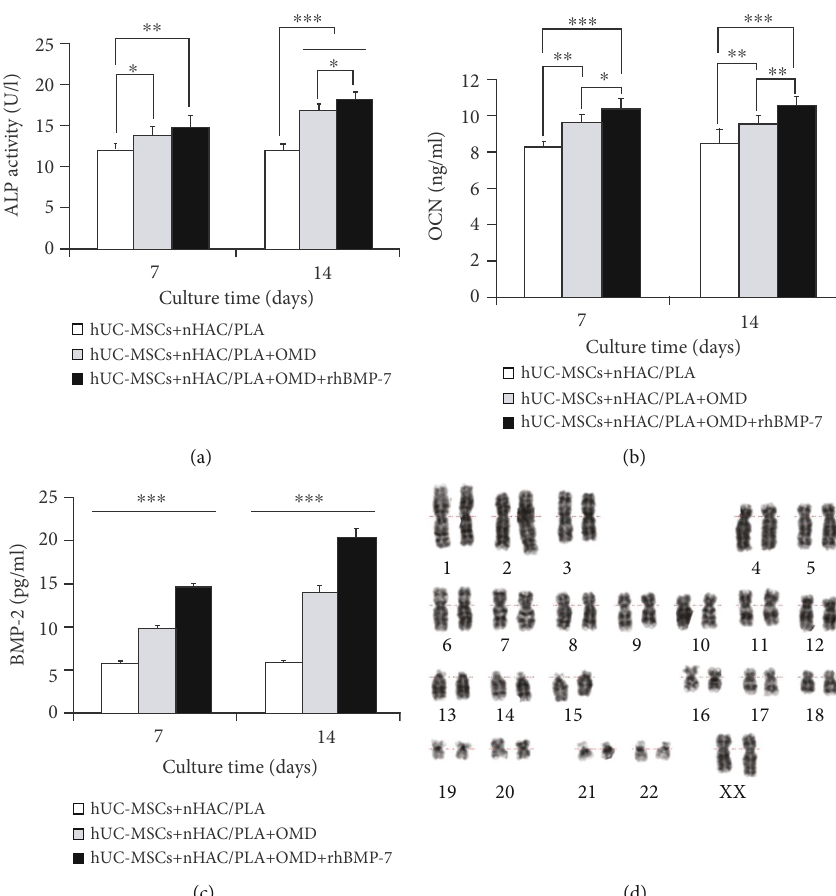
Figure 7: Protein secretion related to osteogenic di ff erentiation in hUC-MSCs in the in vitro three-dimensional culture microenvironment ( mean ± SD , n = 6 ). (a) ALP. (b) OCN. (c) BMP-2. ∗ P < 0 : 05 , ∗∗ P < 0 : 01 , ∗∗∗ P < 0 : 001 . (d) The hUC-MSCs at passage 3 that were cultured on nHAC/PLA in human MSC serum-free OMD supplemented with 100ng/ml rhBMP-7 microenvironment exhibited a normal